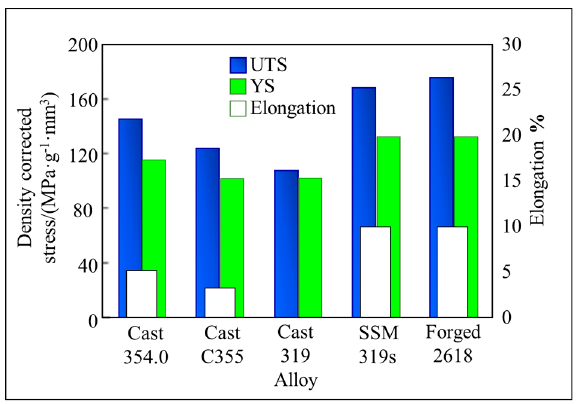
Figure 7. SSM 319 vs. cast C355, 354.0, 319 alloys and forged 2618 alloy after T61 heat treatment [66].